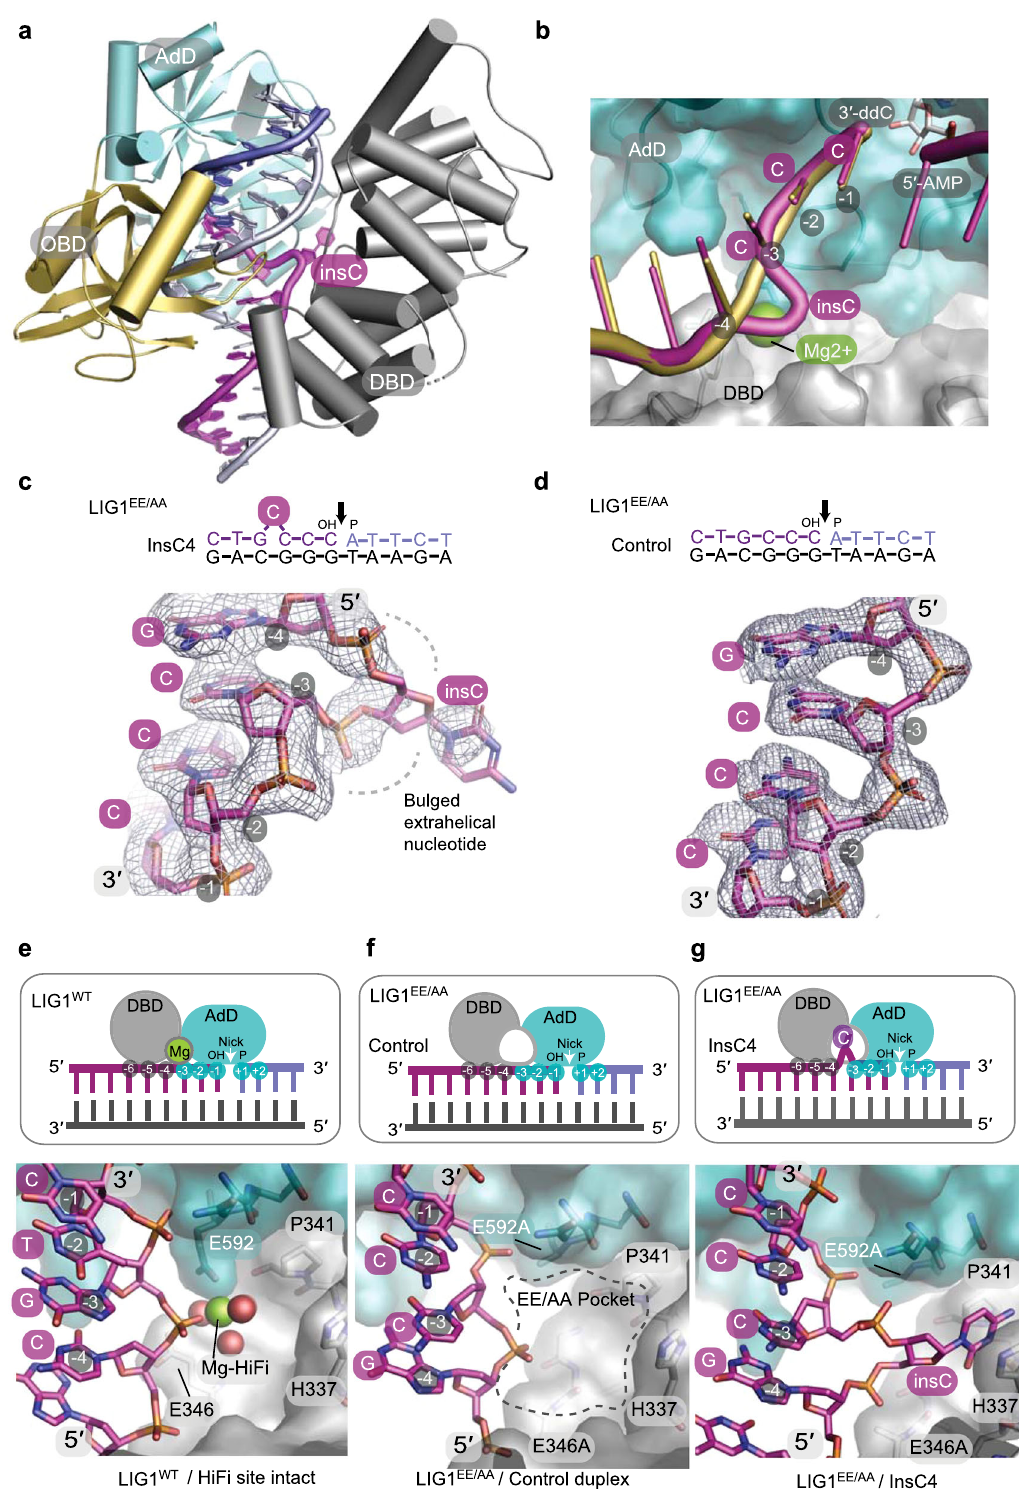
Methods Yeast strain construction and growth analysis . S. cerevisiae strains are isogenic derivatives of strain Δ |( − 2)| − 7B-YUNI300 ( MATa CAN1 his7-2 leu2 Δ :: kanMX ura3 Δ trp1-289 ade2-1 lys2 Δ GG2899-2900 agp1::URA3-OR1 ) 45 , and relevant geno- types are listed in Supplementary Table 1. The cdc9-E206A-E443A-5FLAG:HphMX6 ( cdc9-EE/AA ) mutant strain was generated using a plasmid containing Cdc9 C- terminally tagged with 5×-FLAG and fl anked by 600bp of upstream and downstream sequences. Mutagenesis was performed using the QuikChange II Site-directed